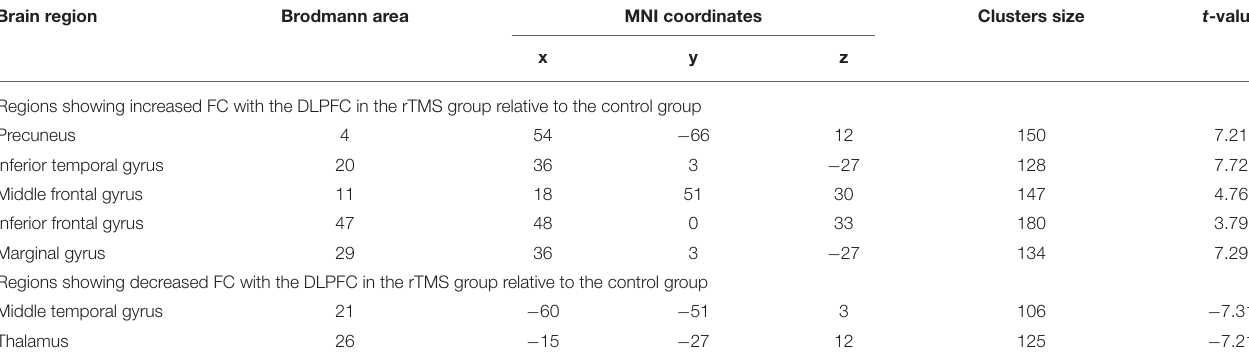
TABLE 4 | Significant differences in FC between the two groups after rTMS or sham stimulation. Brain region